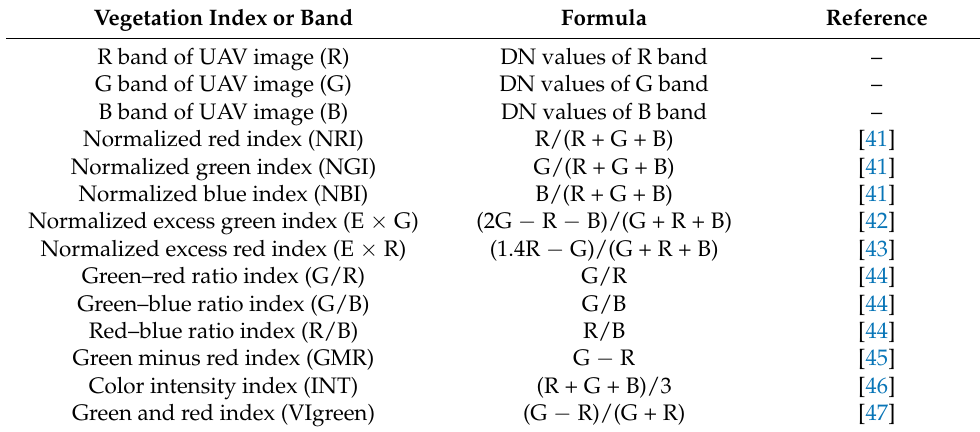
Table 2. Summary of VIs or bands derived from UAV images.